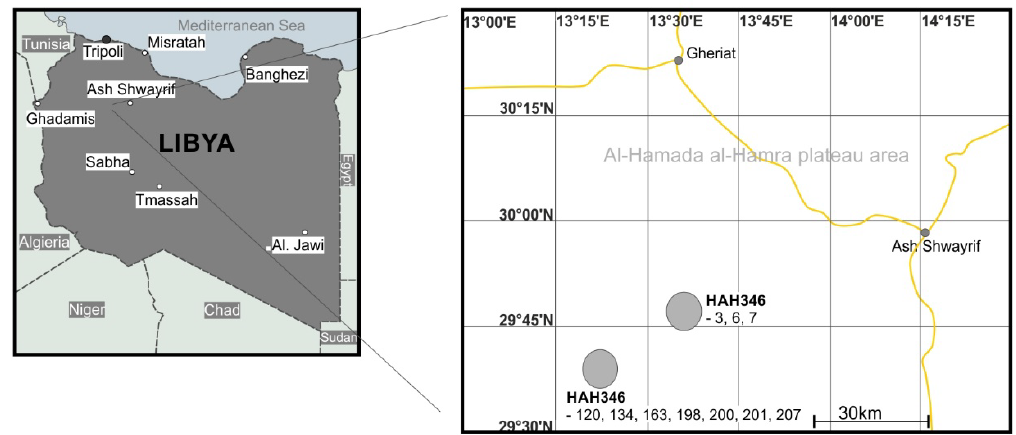
Figure 1. Map of the HaH 346 items found.